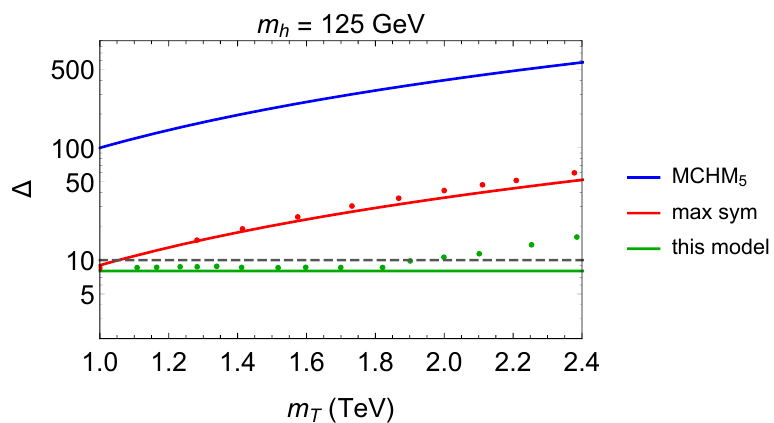
Figure 2: Comparison of the tuning ∆ in several models as a function of the mass of the lightest top partner m . Solid lines correspond to the analytical estimates and T dots to an actual calculation according to Eq. (46). The mass of the vector-resonance ρ is assumed to obey the bound m > 2 TeV. The dashed gray line corresponds to ρ ∆ − 1 =